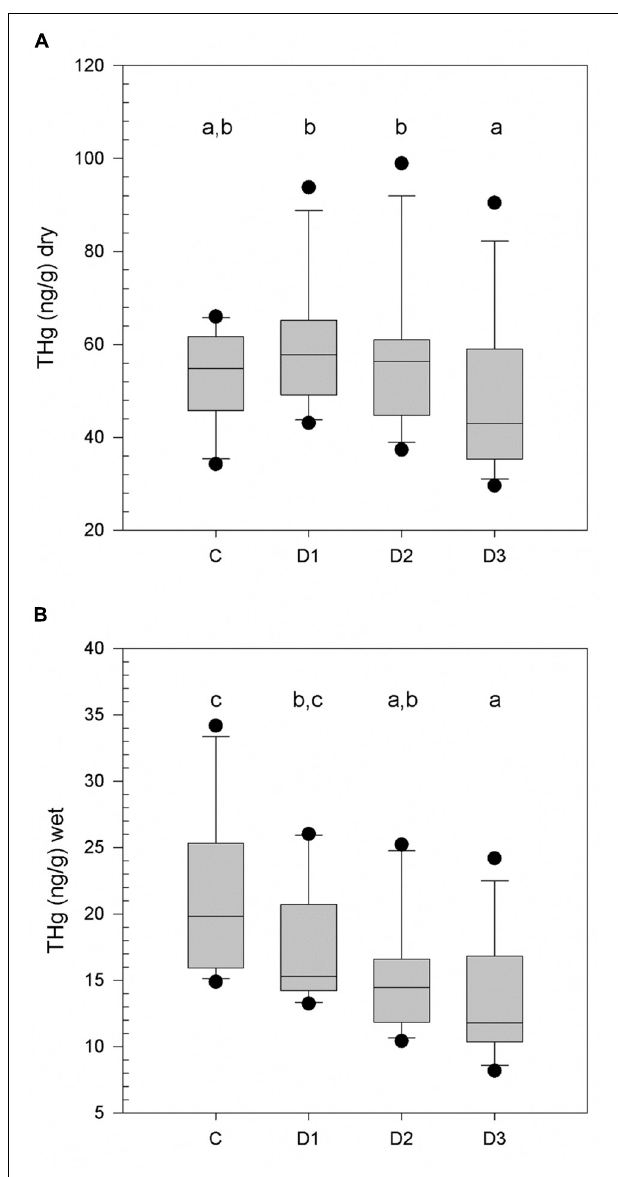
FIGURE 2 | Total mercury concentrations ([THg]) in dry weight (A) and wet weight (B) for eastern gray whales ( N = 15) from different epidermal strata; corneum, spinosum (Depth (D) 1 and 2) and basale (D3). Statistically significant differences in [THg] between strata ( p < 0.05) are indicated by different lower case